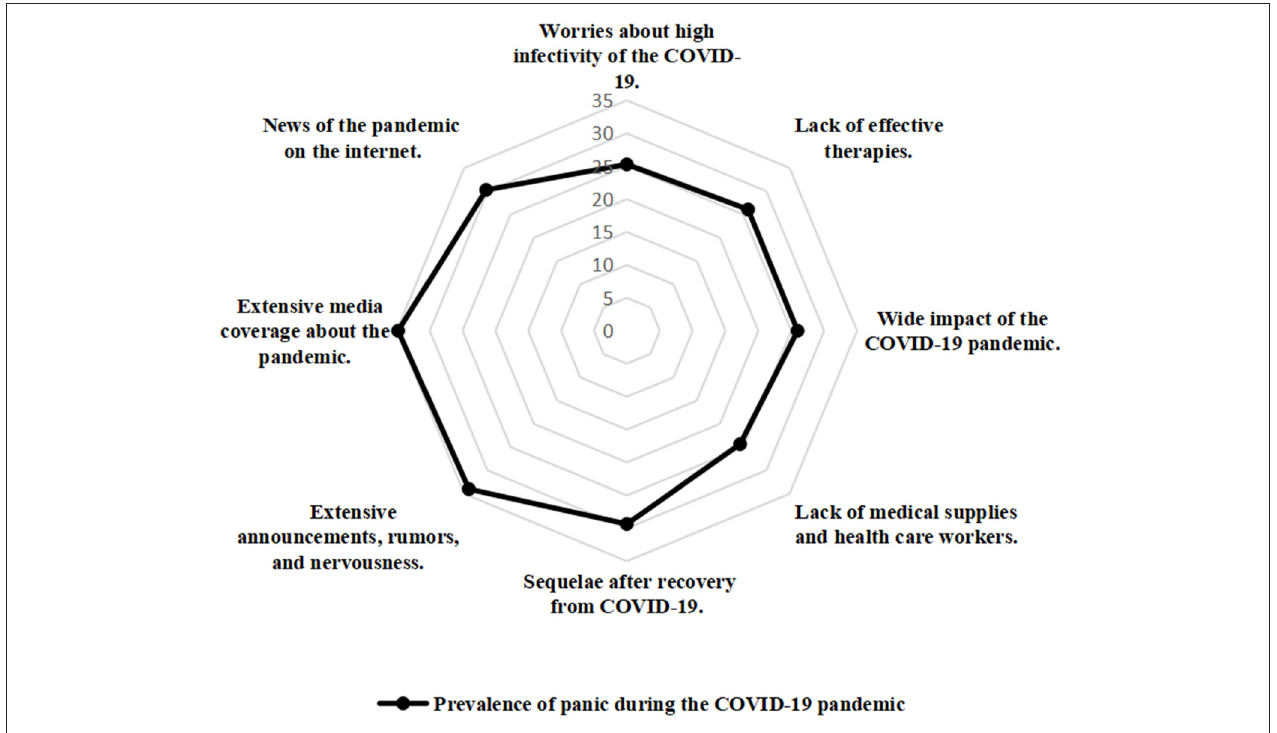
FIGURE 4 | The radar map of the distribution of the public panic (risk perception of the Coronavirus Disease-2019 (COVID-19) pandemic).